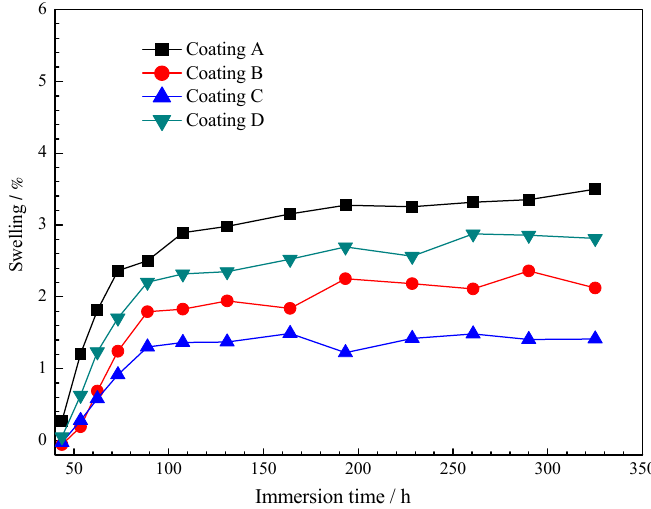
Figure 9. The evolution of coating swelling during exposure to 5 wt.% NaCl solution.